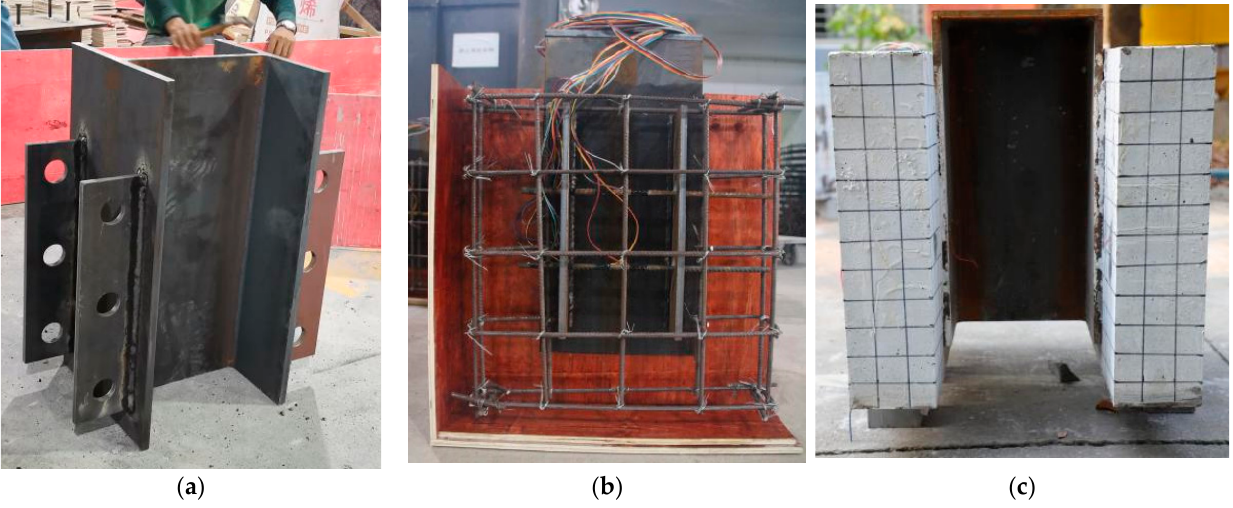
Figure 2. Fabrication of specimens: ( a ) PBL production; ( b ) template assembling; and ( c ) completed specimen.